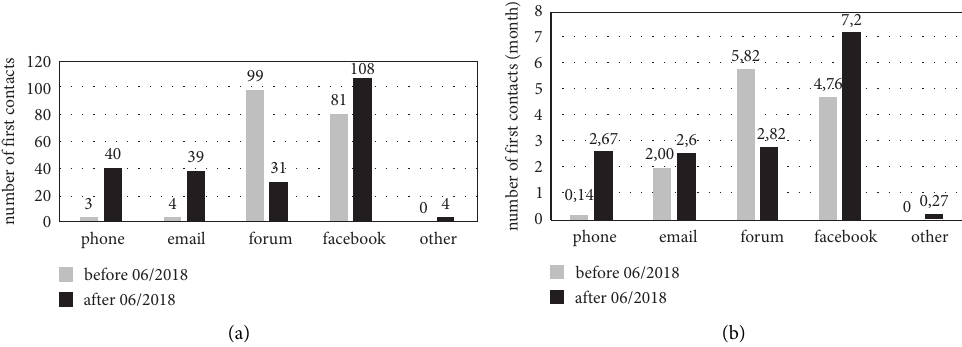
Figure 3: Number of frst contacts via diferent communication channels for diferent calculations and time periods. Tis graph shows the number of all frst contacts documented between September 2016 and 2019 (a) and the average number of frst contacts per months of documentation (b). Tere was a relevant increase in phone contacts after publishing the article. Documentation periods (for explanation see also method section): phone: 09/2016–05/2018 and 07/2018–09/2019; email: 04/2018–05/2018 and 07/2018–09/2019; forum: 01/2017–05/ 2018 and 07/2018–04/2019; facebook: 01/2017–05/2018 and 07/2018–09/2019. In total 4 patients got into contact with the German self-help group via other communication channels (“other”: 2x via the facebook ® homepage of the self-help group for patients with pulmonary hypertension, 1x indirect via friends who were contacting the German self-help group via facebook ® and 1x directly via the general